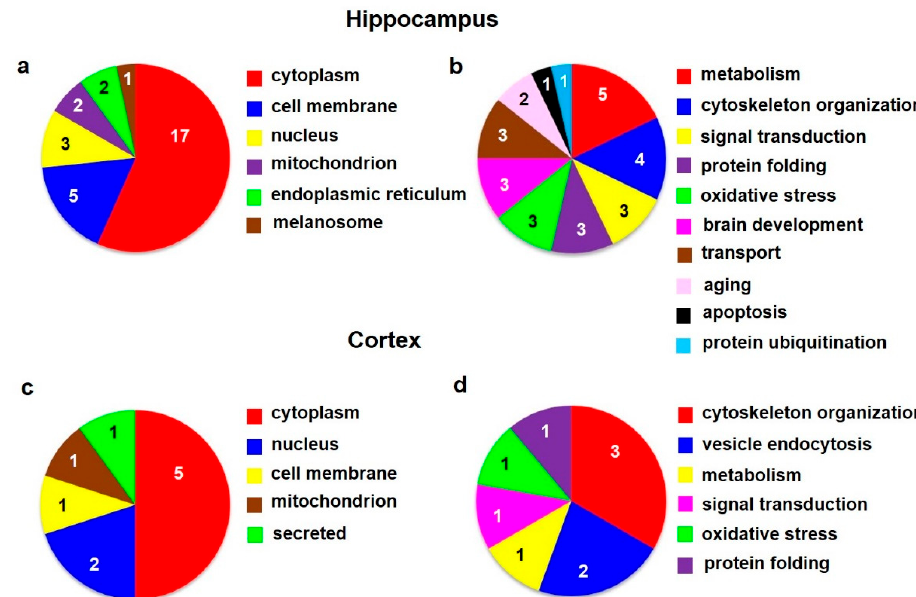
Figure 1. Representative 2D gel maps of phosphorylated proteins ( a ) and total protein profiles ( b ) in the rat hippocampus isolated from animals after 6 months of morphine withdrawal. Red arrows and numbers show the significantly altered protein spots.